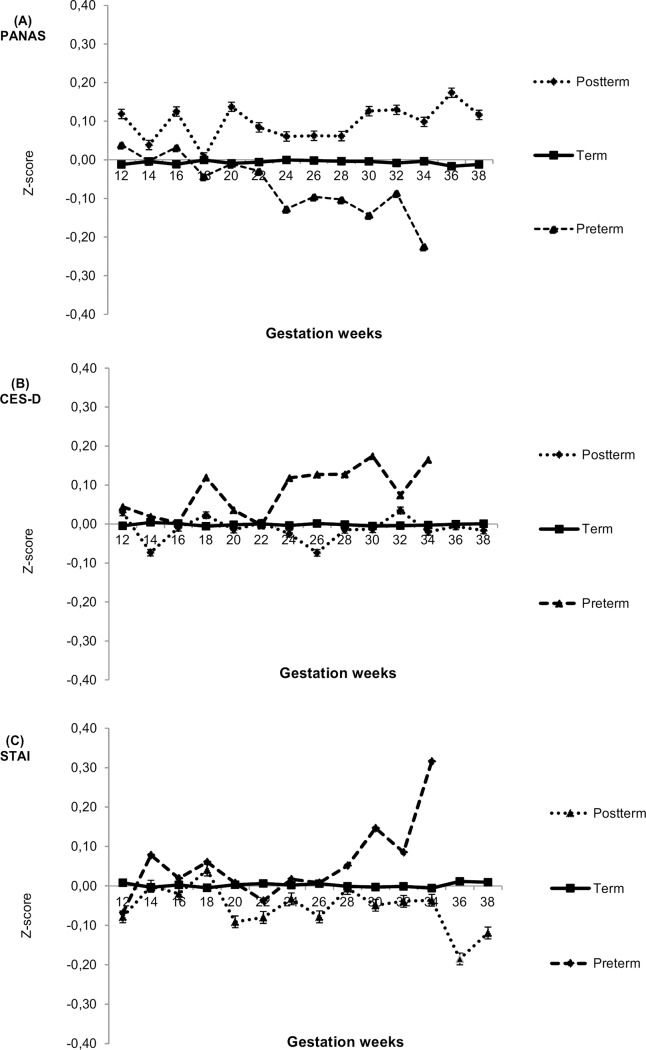
Trajectories of maternal (A) positive affect (PANAS), (B) depressive symptoms (CES-D), and (C) anxiety symptoms (STAI) at two-week intervals according to preterm (≤ 36 6/7 gestational weeks), term (37 0/7-41 6/7 gestational weeks) and post-term delivery (≥ 42 0/7 gestational weeks).